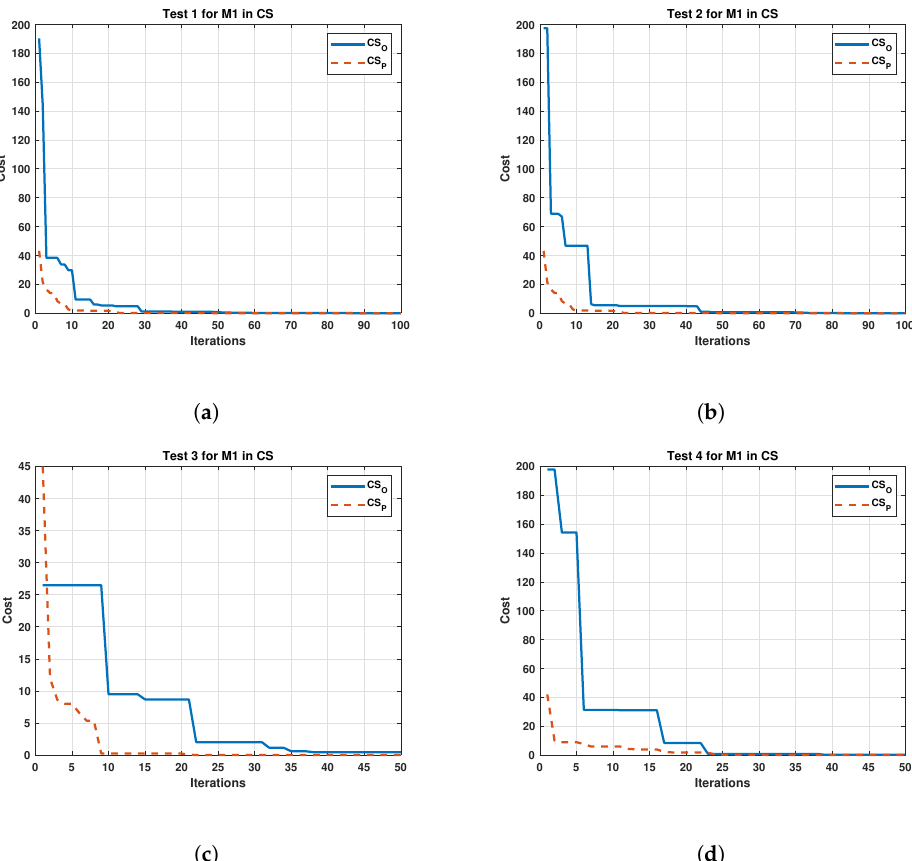
Figure 10. Comparison between the original and the proposed Cuckoo Search in four tests for Motor 1. ( a ) cost and iterations of the Cuckoo Search in test 1 for Motor 1; ( b ) cost and iterations of the Cuckoo Search in test 2 for Motor 1; ( c ) cost and iterations of the Cuckoo Search in test 3 for Motor 1; ( d ) cost and iterations of the Cuckoo Search in test 4 for Motor